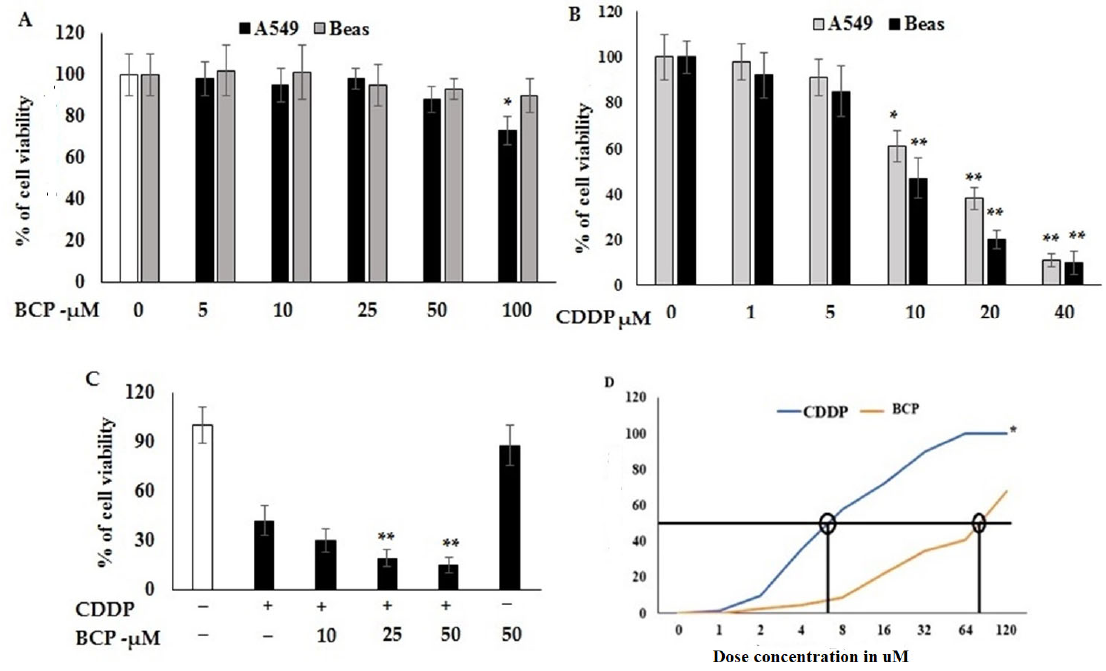
Figure 1. Effect of Beta-Caryophyllene alone and in combination with cisplatin on proliferation activity of lung cancer cell line, A549, and normal lung cell line, Beas. After 48 h of treatment, the control group (DMSO) on the extreme left is assigned 100% viability and cells proliferation was performed using MTT assays. Viability of cells treated with BCP ( A ) and CDDP ( B ). Cells were treated with various concentrations of BCP in the presence or absence of CDDP ( C ). Synergistic dose based on the IC 50 values was confirmed for both BCP/CDDP at 75 μ M and 7 μ M, respectively ( D ). Values shown are mean ± SD for three independent experiments. * p < 0.05, significant variation and ** p < 0.01 high significance variation versus DMSO ‐ or CDDP ‐ treated cell lines.